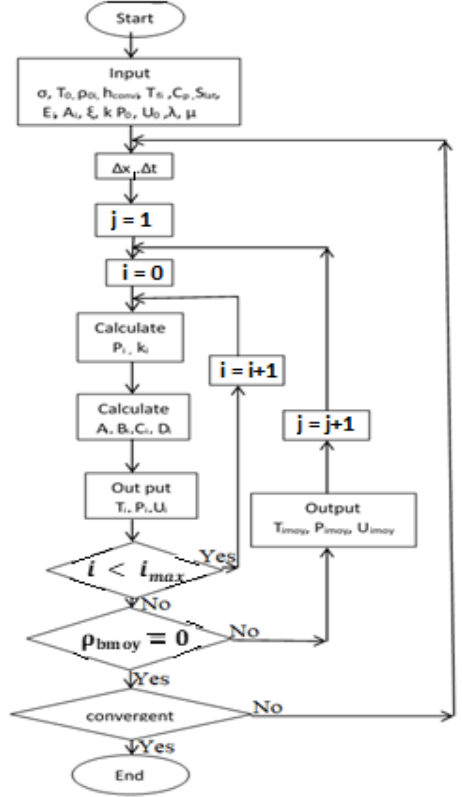
Figure 3. Flowchart for predicting numerical results of the process .